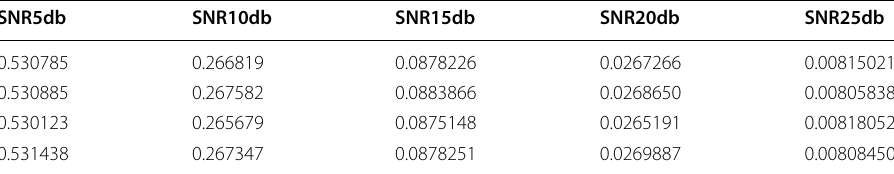
Table 2 The optimal PS factor in DF mode with 4